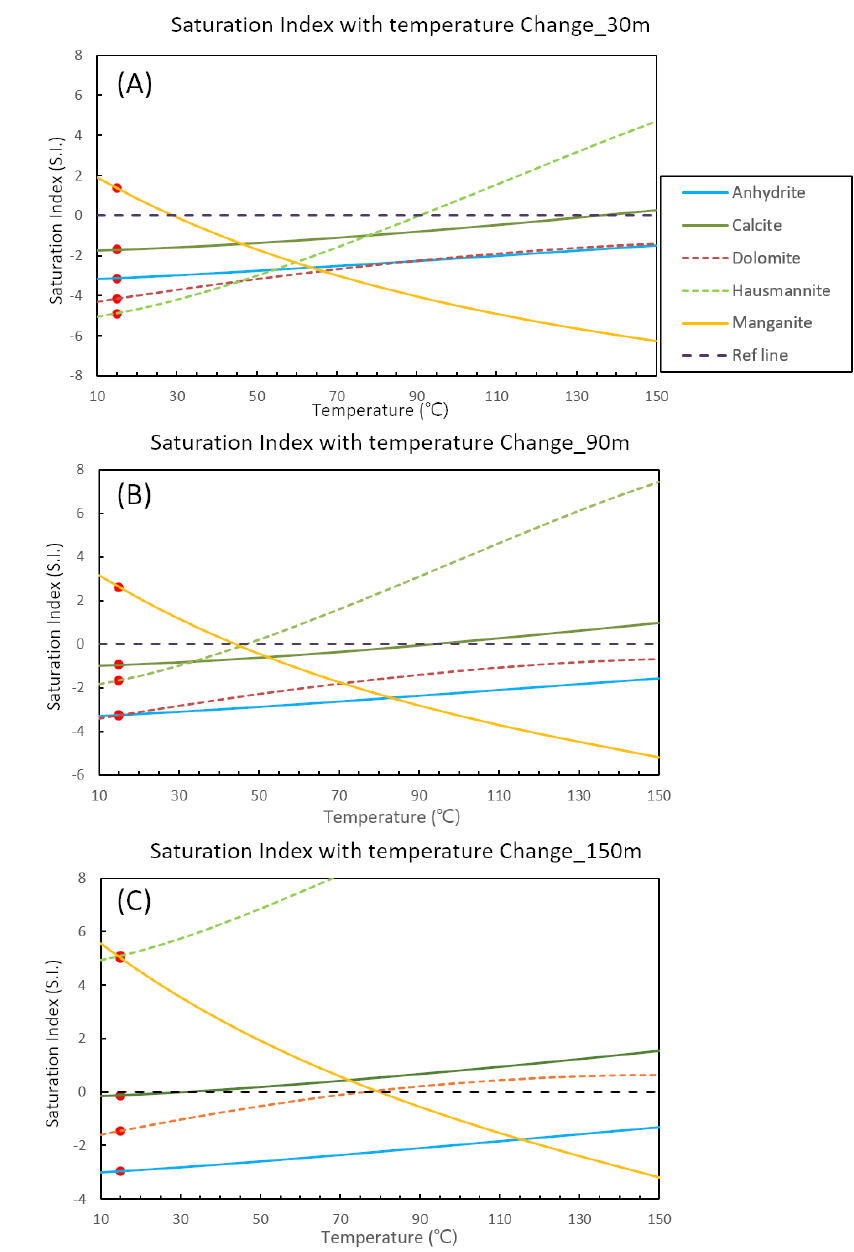
Figure 8. Saturation index diagram for samples collected at depths of 30 m ( A ), 90 m ( B ), and 150 m ( C ). This figure shows changes in the saturation degree of target minerals with increasing temperature. Red plots: actual data, which match the modeling